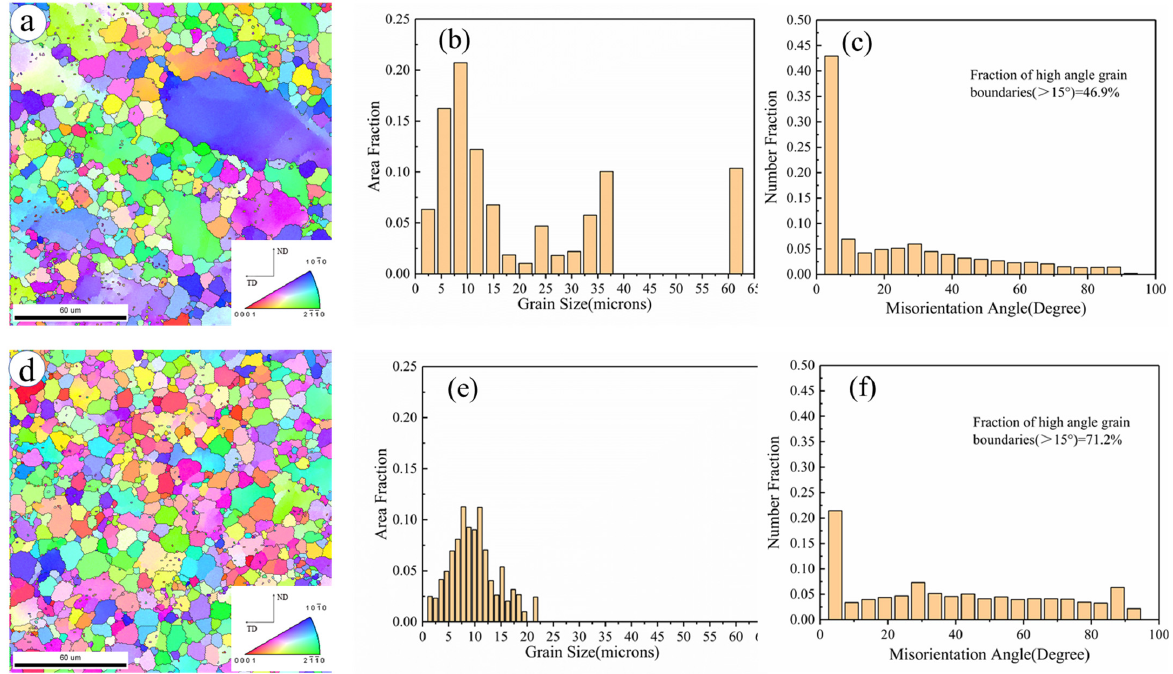
Figure 6. ( a , d )The inverse pole figures, ( b , e ) misorientation angle distributions, and ( c , f ) grain size distributions of ( a – c ) the C-as-extruded and ( d – f ) the C-6 P-593 K. Figure 7 shows the (0 0 0 1) pole Figures of the C-as-extruded and the C-6 P-593 K. The C-as-extruded possessed a single (0 0 0 1) texture, in which the (0 0 0 1) basal plane paralleled to ED-axis. The texture is typical for magnesium alloys processed by hot ex- trusion [33]. The texture of the C-6 P-593 K changed and was divided into two kinds of texture. One, which corresponds to area A in Figure 7b, indicates the (0 0 0 1) basal plane parallel to the ND plane. The other one, which corresponds to area B in Figure 7b, indi- cates that the angle between the normal direction of (0 0 0 1) basal plane and the ED-axis is 60 degrees. It is supposed that the substantial shear stress, which also possessed an angle of 60 degrees with the ED-axis, contributes to the formation of the second texture type during the ECAP process. Figure 7. The (0 0 0 1) pole figures for α -Mg phase in ( a ) C-as-extruded and ( b ) C-6 P at 593 K. 3.4. Mechanical Properties